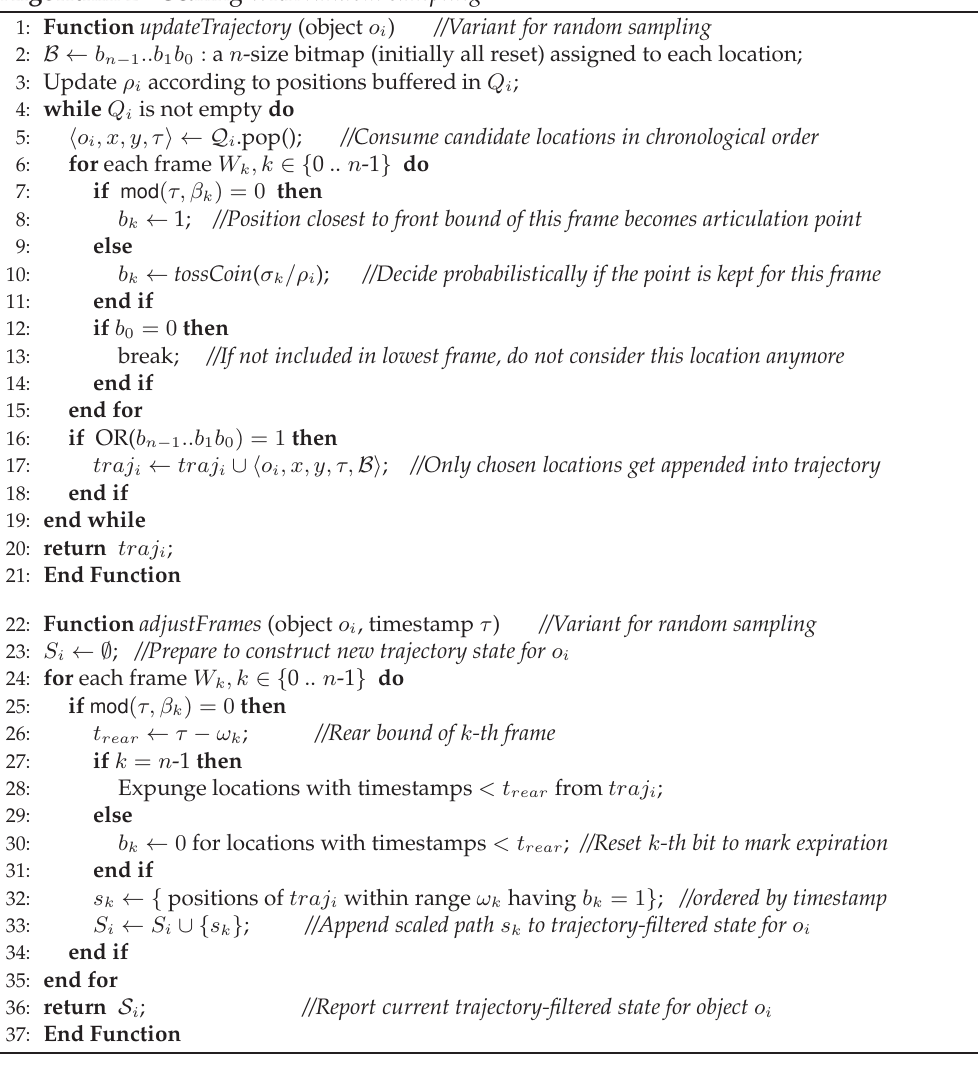
Algorithm 2 Scaling with random